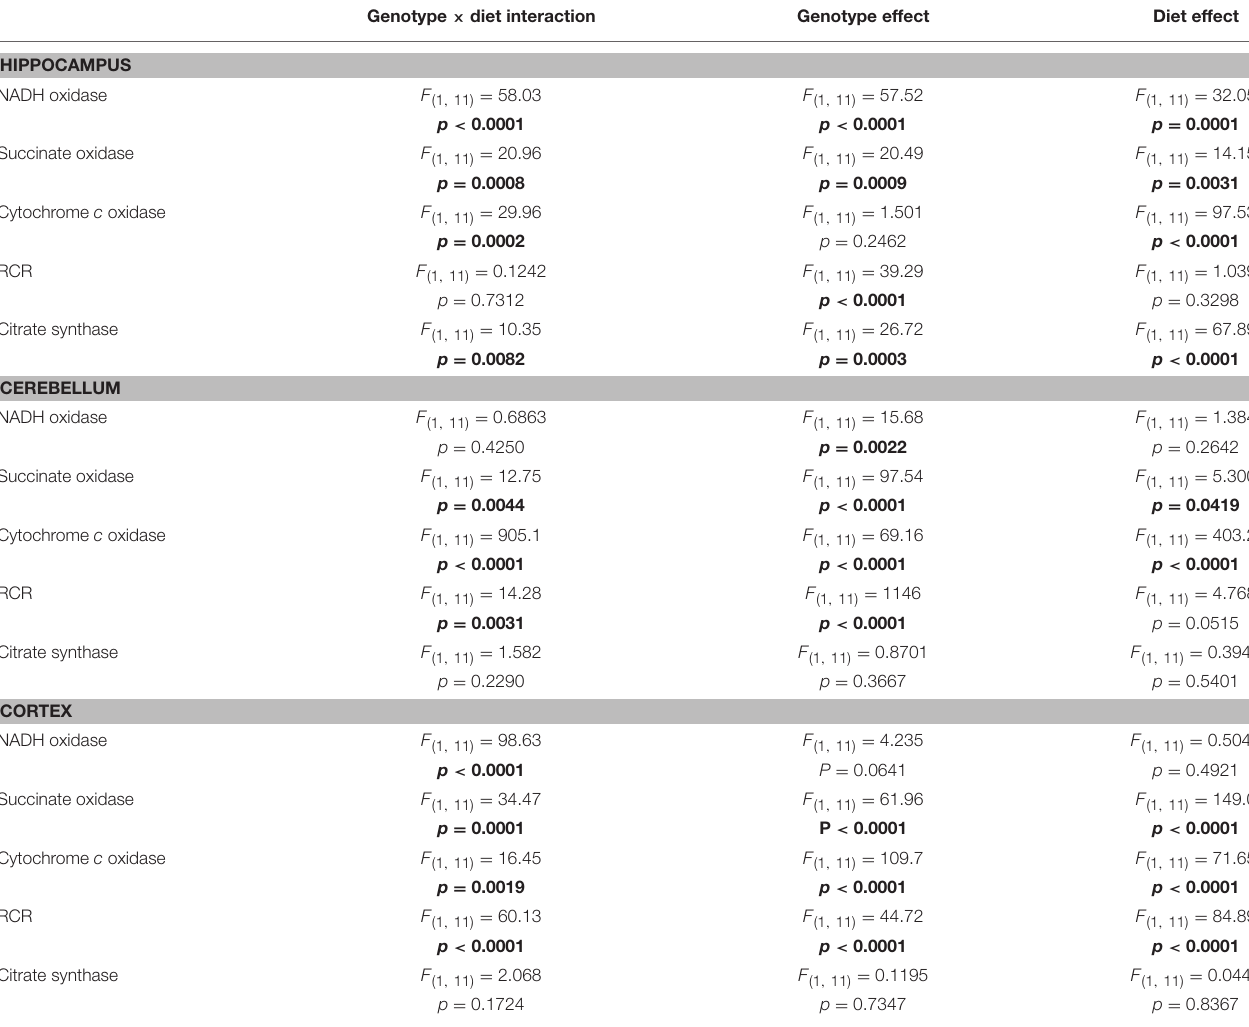
TABLE 4 | Effect of genotype, diet, and genotype × diet interaction on outcomes evaluated in hippocampus, cerebellum, and cortex of cross-fostered WT and KI